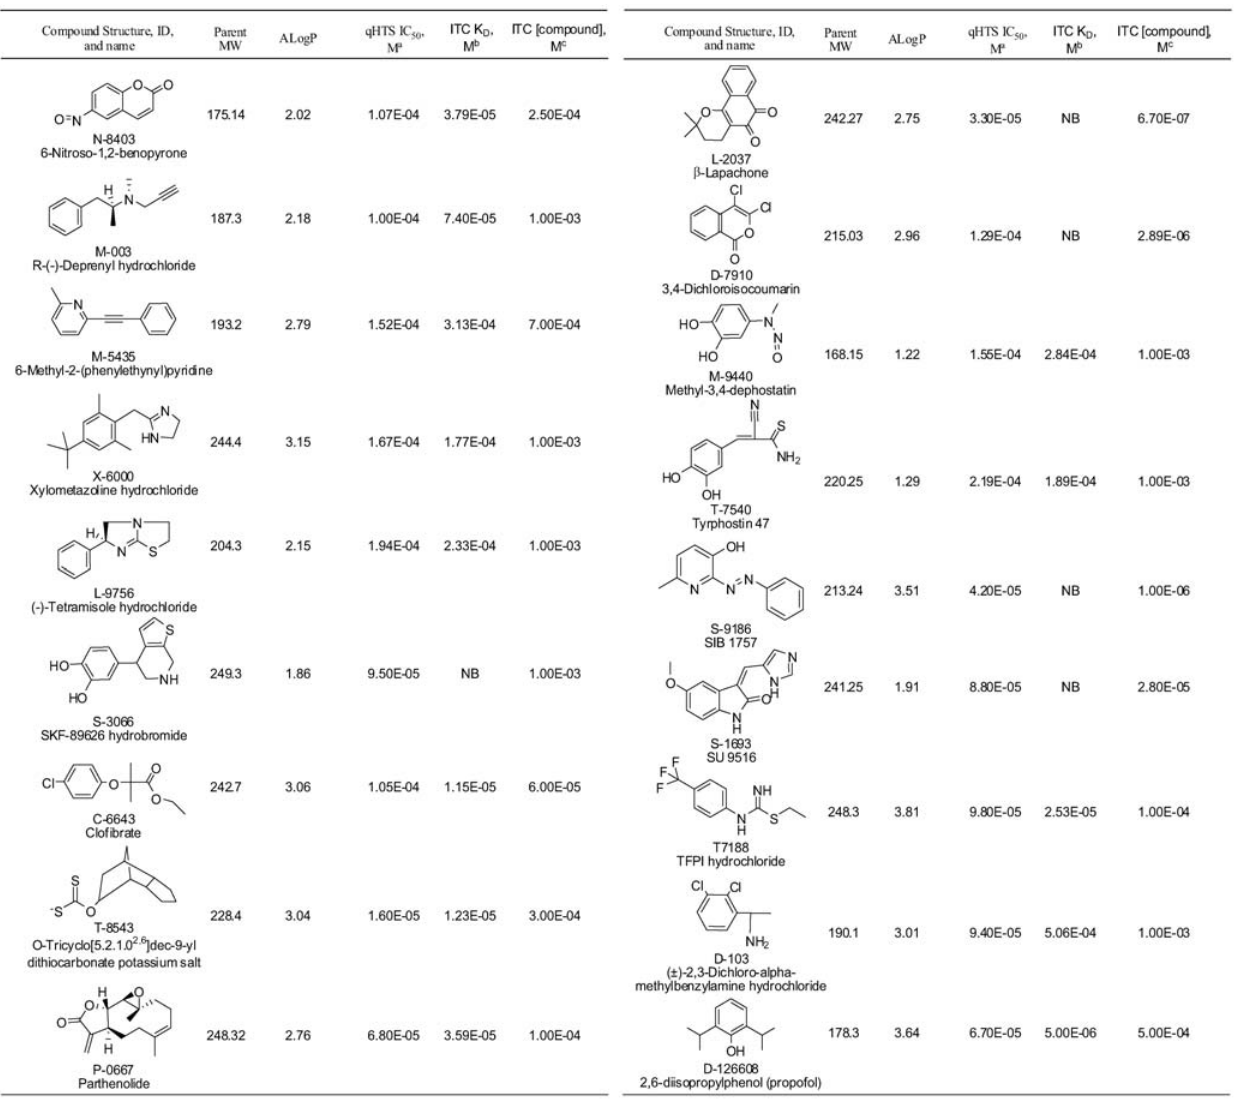
Figure 6. Final compound characteristics and binding summary. Shown are the eighteen compounds, their stick structures and chemical names. The qHTS IC 50 is computed directly from the 1-AMA inhibition data, in molar units, fixing the infinite value to 2 70%. The ITC K D is derived from single class fits to enthalpograms (n=1), and is in molar units (NB = no binding). The ITC [compound] column represents the molar concentration of compound achieved after mixing and filtration prior to loading into ITC syringe. Target concentration was 1 mM in each case, but clearly not achieved in all. Compound concentrations were measured with UV absorbance.